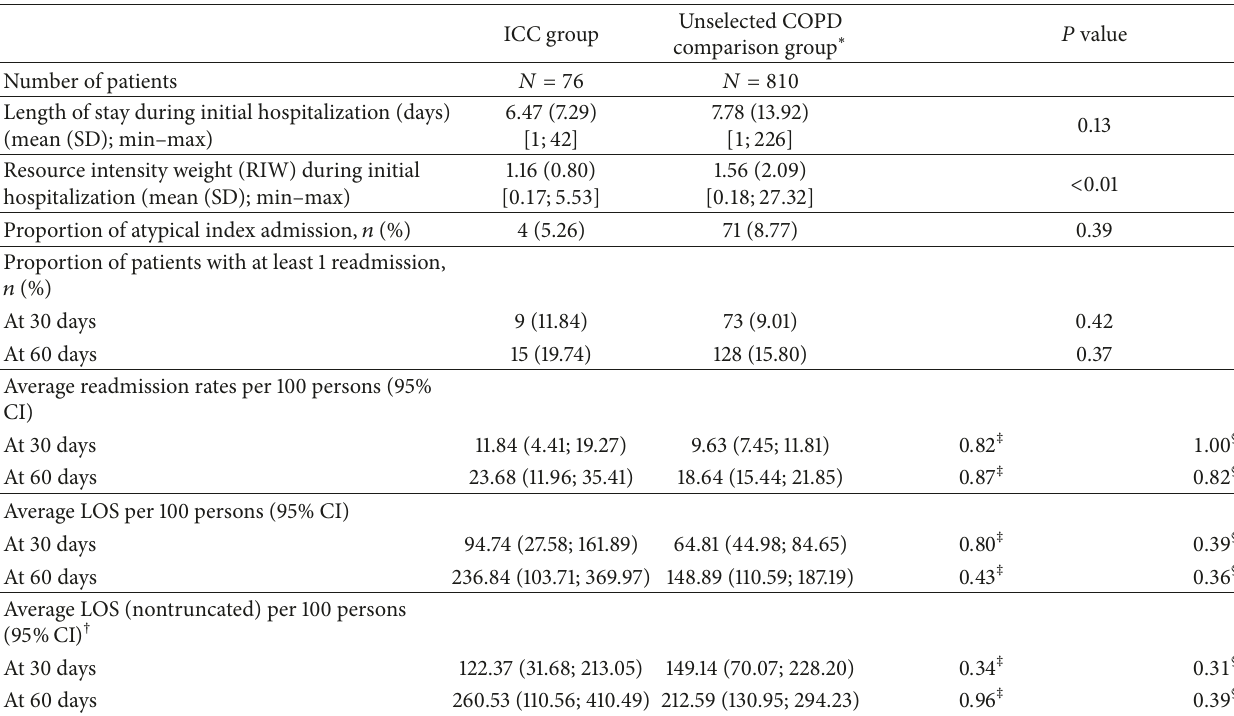
Table 6: Example of the unadjusted analyses using the inappropriate COPD comparator group. ICC group